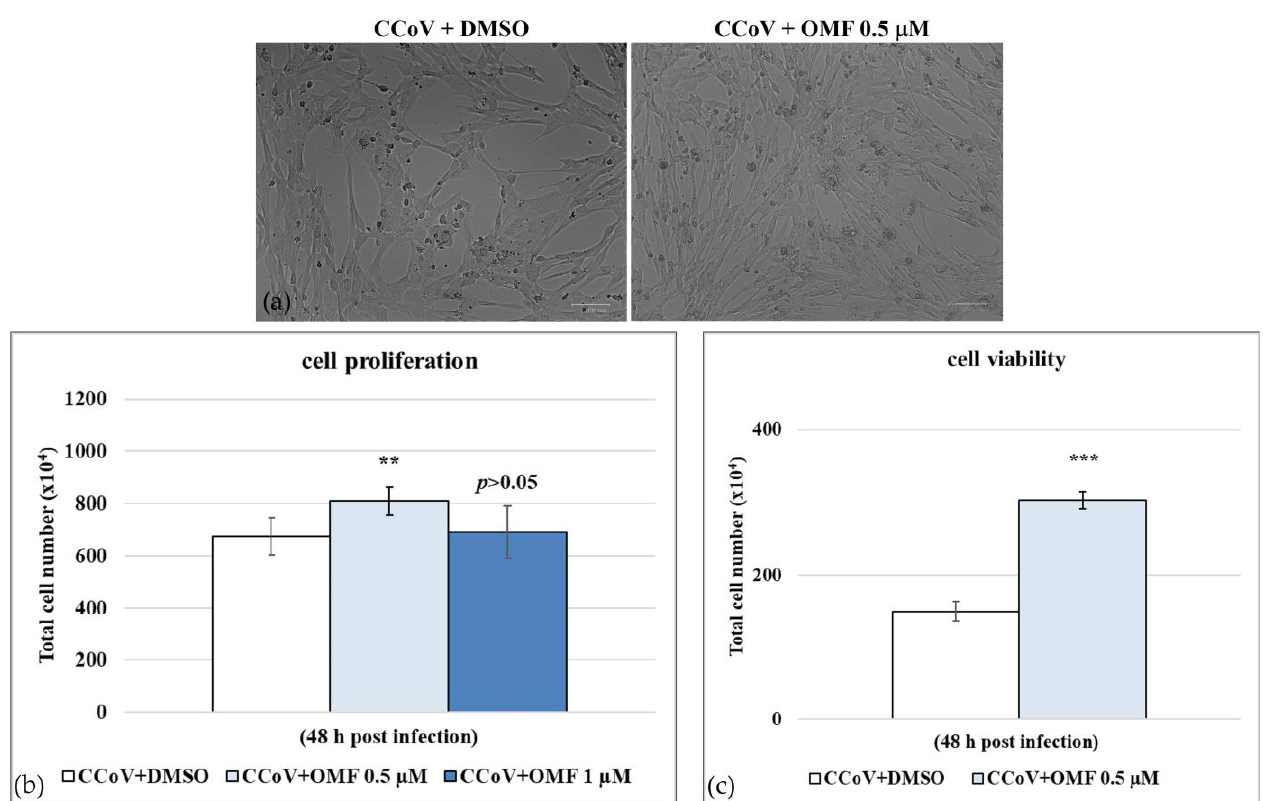
Figure 3. OMF reduced cell death during CCoV infection in A72 cells. ( a ) Cells infected with CCoV and exposed to OMF at various doses (0.5 and 1 μM) a t 24 h after infection. ( b ) Dose – response curve of cells infected with CCoV, exposed to OMF (0.5 μM) for 48 h and tested using an MTT assay. ( c ) Dose – response curve of cells infected with CCoV, stained using TB and scored using a light microscope. Scale bar 100 μ m. Significant differences between infected and OMF-exposed infected cells were indicated by probability p . ** p < 0.01 and *** p < 0.001.